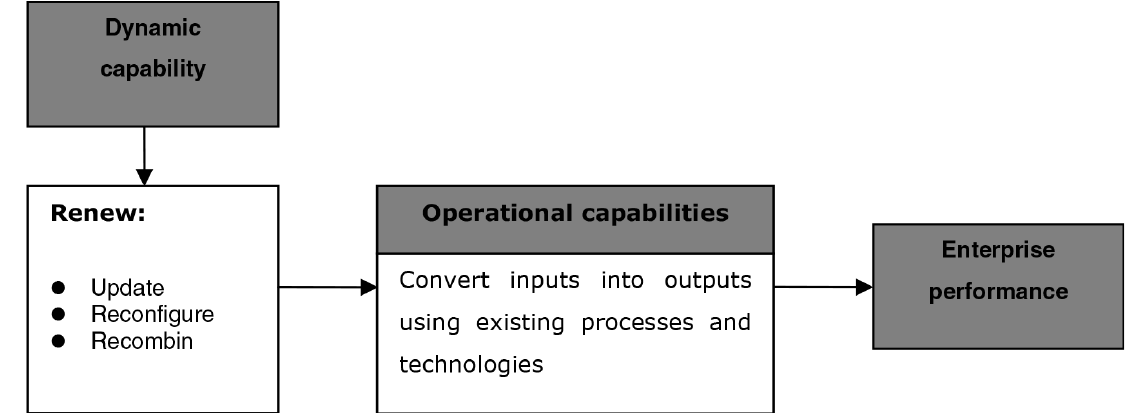
Figure 1. Dynamic capability framework (Teece et al.,